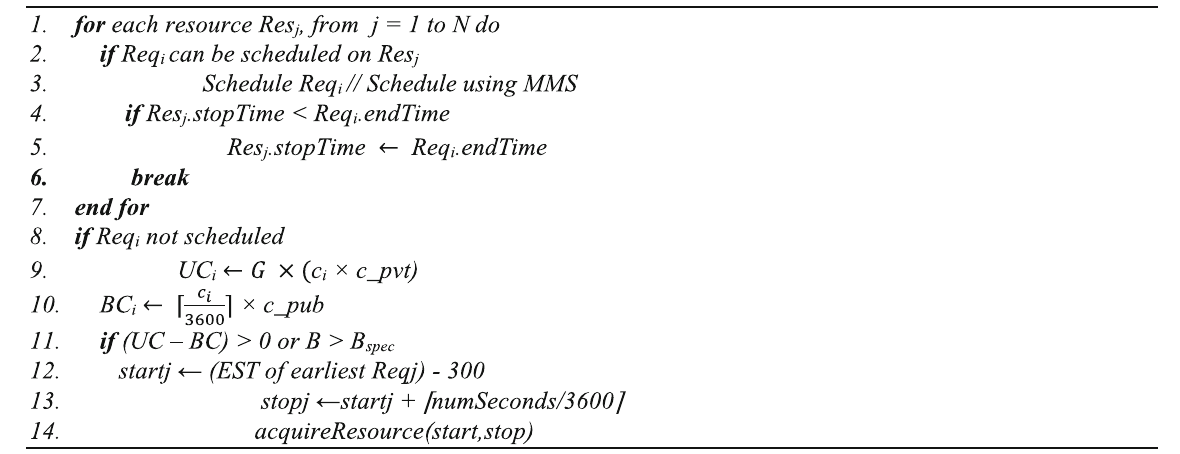
Table 1 Reactive Auto-Scaling